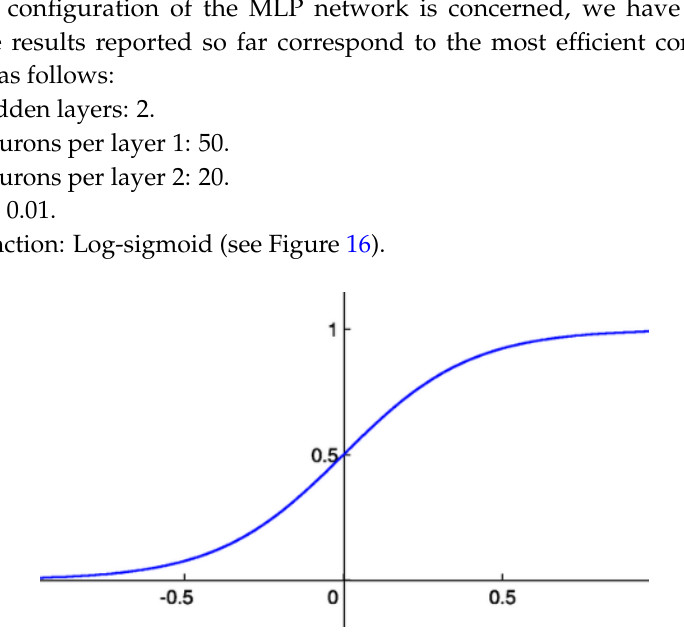
Figure 16. Log-sigmoid transfer